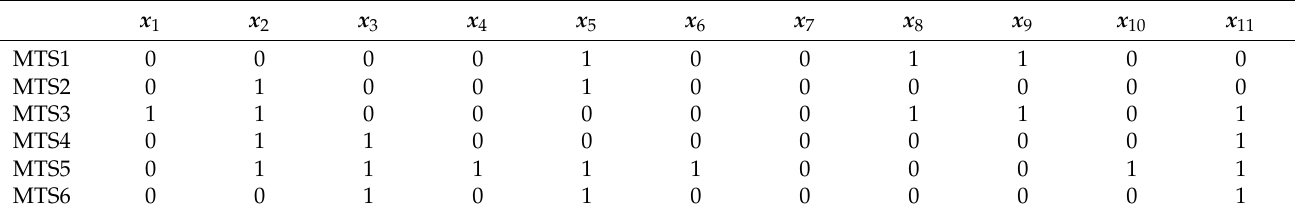
Table 7. Feature variable selection results of Optimized BT-MTS of the Wine quality-white data set.